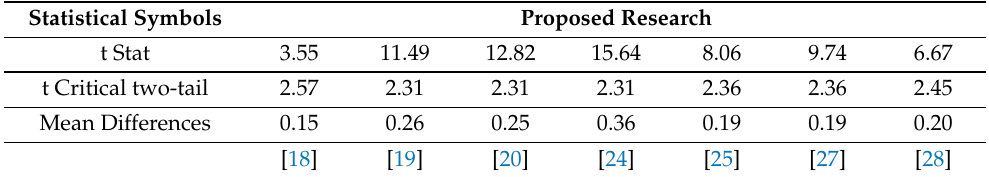
Table 6. Statistical hypothesis testing for proposed framework and previously published works. Statistical